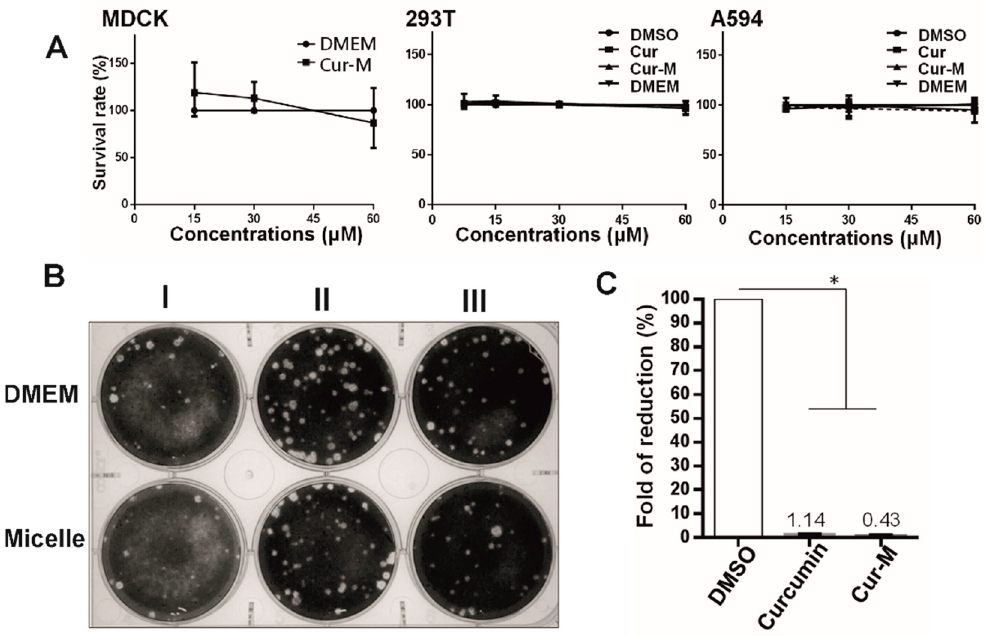
Figure 3. ( A ) Cytotoxicity of curcumin and Cur-M. Cytotoxicity was estimated based on the cell survival rate. In brief, three cell lines (Madin–Darby canine kidney (MDCK), 293T, and A549) commonly used for influenza propagation were treated with various concentrations of curcumin, Cur-M, and DMSO for 24 h. Cell survival rate was monitored by total vital cells counts in each treated group relative to that of mock control sample. Results from three independent experiments were plotted. ( B ) The effect of the micelle on the plaque-forming ability of the influenza virus was initially determined by a time-of-drug-addition assay, in which the tested compounds were added to the culture medium at 16 h prior to infection (pre-treatment, I), at the time of virus infection (co-treatment, II), or after viral adsorption (post-entry treatment, III). ( C ) The effect of curcumin and Cur-M on viral production. MDCK cells were continuously treated with DMSO, 30 µM curcumin, or Cur-M during influenza A virus (IAV, 2000 pfu) infection. At 24 h post-infection (hpi), the yield of viral progenies was determined. The yields relative to the mock treatment from three independent experiments were plotted. Statistically significant differences compared with the DMSO group are indicated by * ( p < 0.05).